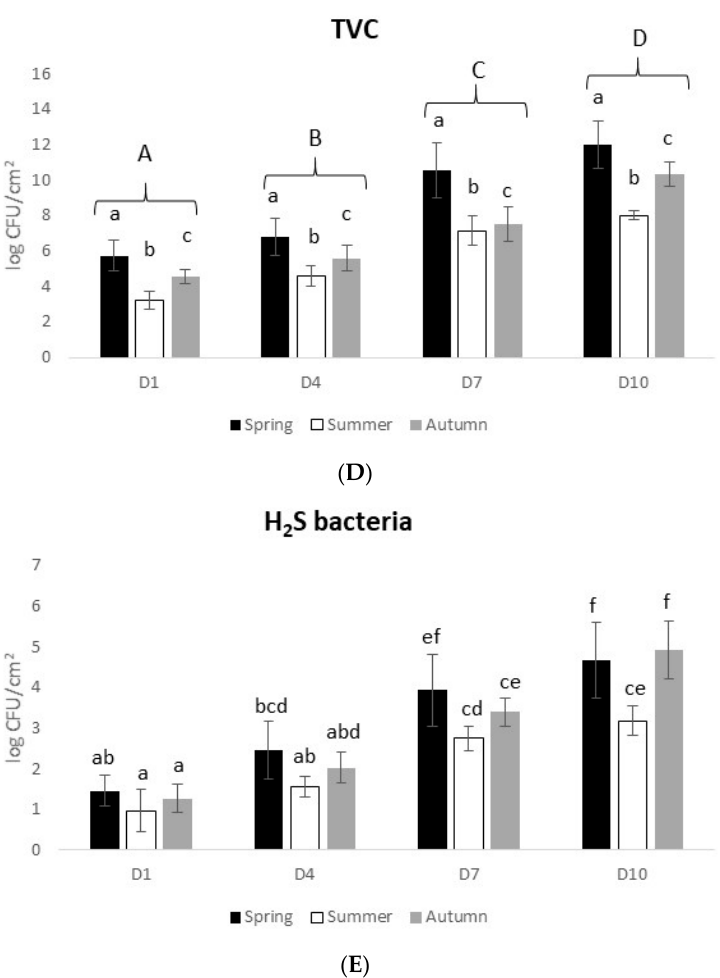
Figure 4. Seasonal Atlantic chub mackerel freshness profile over 10 days on ice, assessed by different methods: ( A ) Quality Index Method, ( B ) EC scheme, ( C ) Torrymeter (TRM), ( D ) microbiology (TVC), and ( E ) microbiology (H 2 S-producing bacteria). Values represent mean ± SD ( n = 6). In Figure 4B–D, different uppercase letters indicate significant differences among days, while different lowercase letters indicate significant differences among seasons. In the other figures, different letters indicate significant differences among treatments.